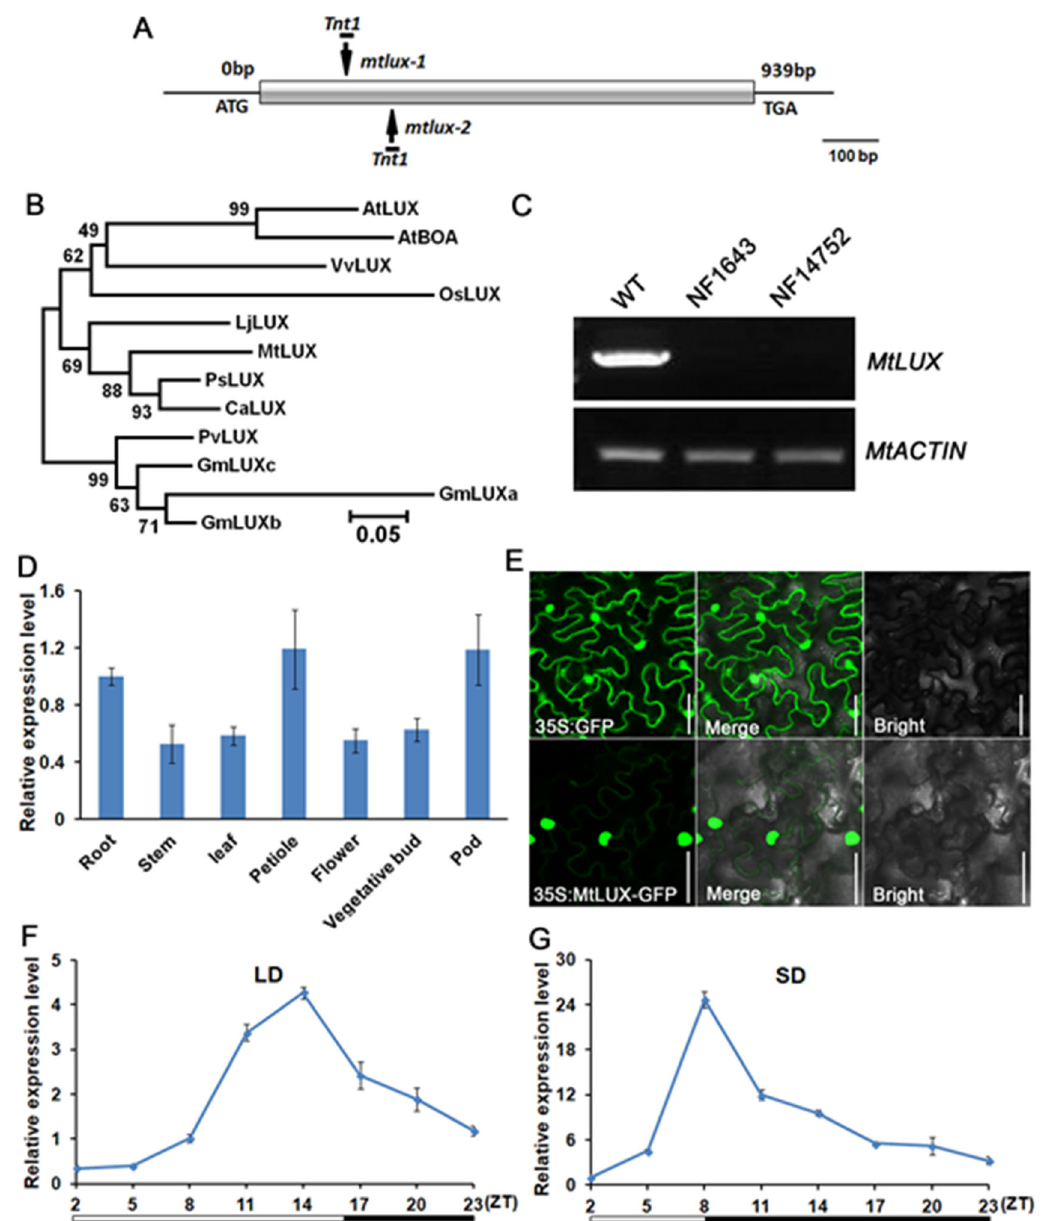
Figure 2. Molecular cloning and expression pattern of MtLUX in M. truncatula . ( A ) Schematic representation of the MtLUX gene structure and Tnt1 insertion site. Box represents exon and